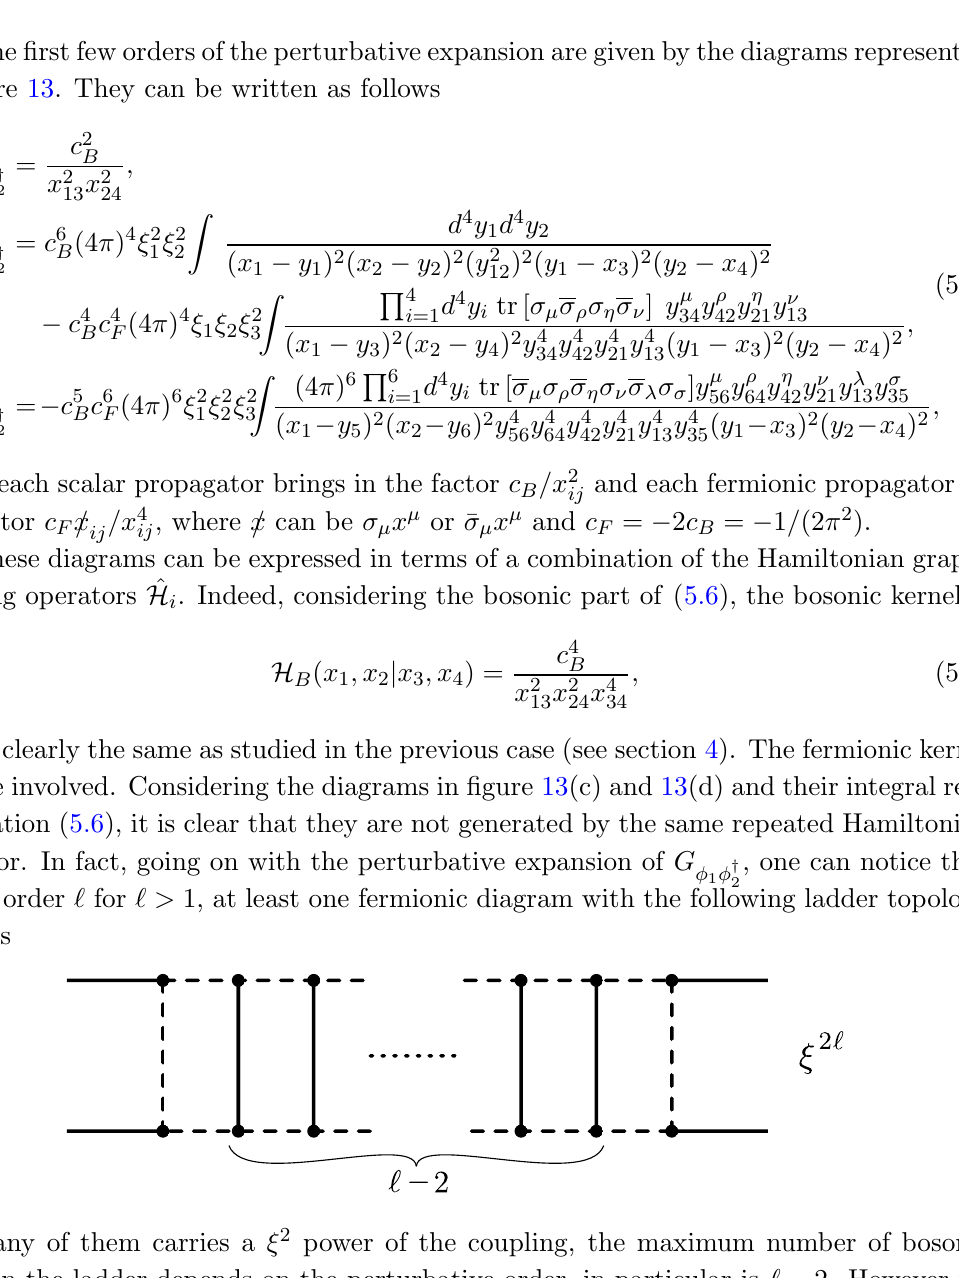
(cid:30) 1 (cid:30) y 2